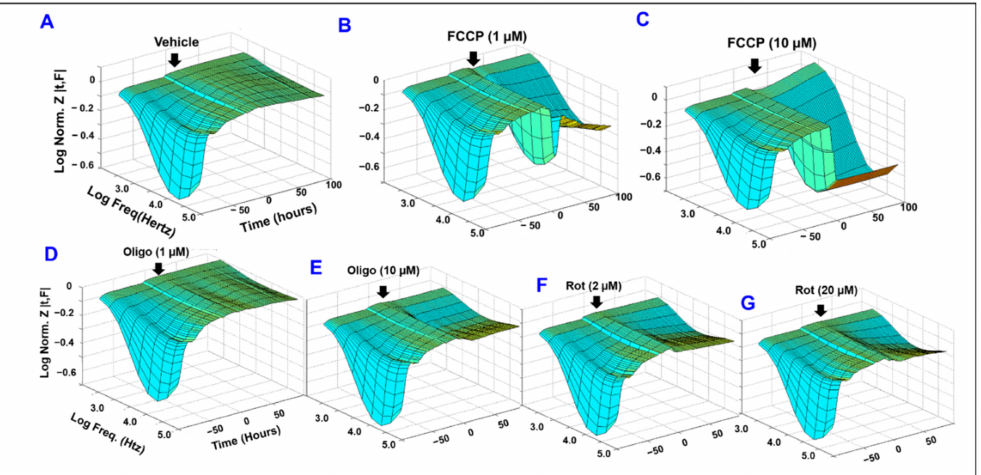
Figure 1. Comparative Effects of different mitochondrial components on RPE barrier functionality using real-time bioimpedance analysis. Effects of FCCP, oligomycin (oligo), and rotenone (Rot) on the barrier function of ARPE-19 cells as measured in real-time by the ECIS system. Three-dimensional plots of Log Normalized Impedance (Z) as a function of both time and of log of the frequency of the 1 µ A alternating current (AC) applied to the ECIS electrode. Treatments were applied to the cell groups at T = 0, which was 94 h after cells were placed onto the ECIS electrode, a point at which the cells had already become confluent. Impedance across the cells was measured for 100 h after addition of either control vehicle ( A ), FCCP at concentrations of 1 µ M or 10 µ M (( B , C ), respectively), oligomycin at concentrations of 1 µ M or 10 µ M (( D , E ), respectively), or rotenone at concentrations of 2 µ M or 20 µ M (( F , G ), respectively). Z 0 , the impedance at T 0 , was normalized to a value of 1, and all other impedance values were calculated as the ratio Z t /Z 0 . AC current frequencies used were 250, 500, 1000, 2000, 4000, 8000, 16,000, 32,000, and 64,000 Hz. Abbreviations: Z, impedance; Norm, normalized; FCCP, trifluoromethoxy carbonylcyanide phenylhydrazone; Oligo, oligomycin; Rot, rotenone; Freq, frequency; Z t , impedance at time t; Z 0 , impedance at time T = 0. Data shown are representative three-dimensional plots of 5–6 independent biological replicates per